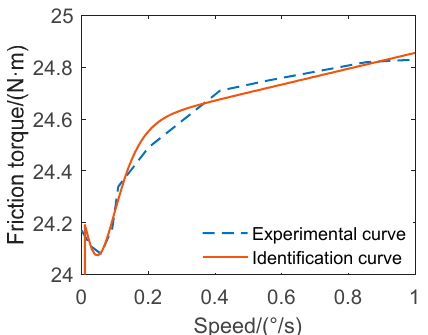
Figure 4. Torque diagram of a continuous friction model.